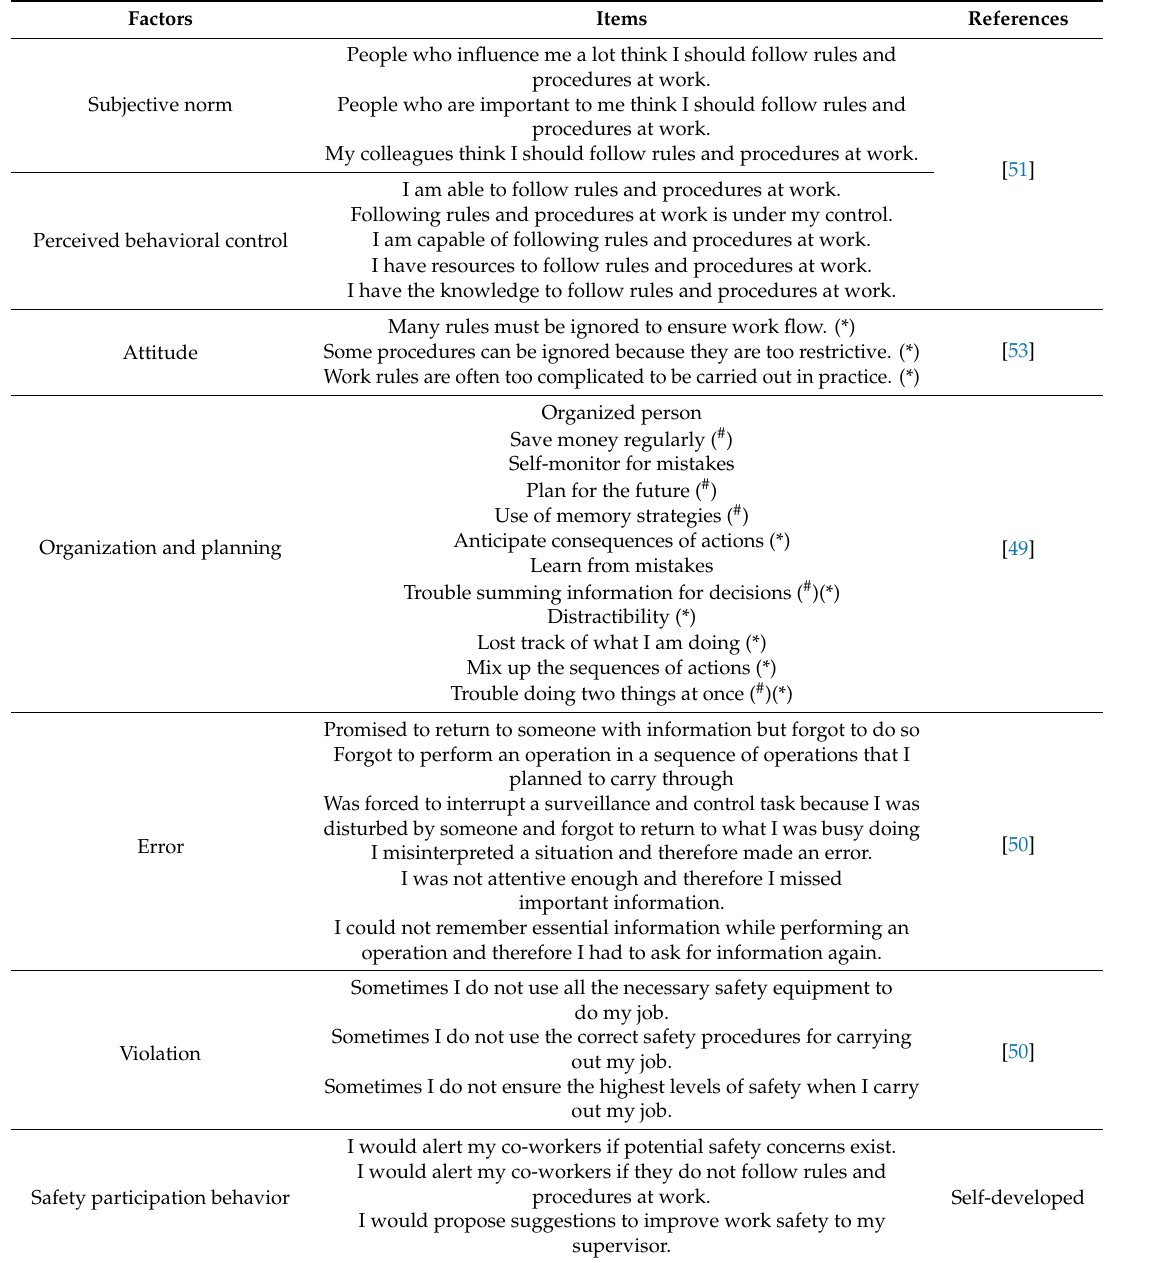
Table A1. List of items used in this